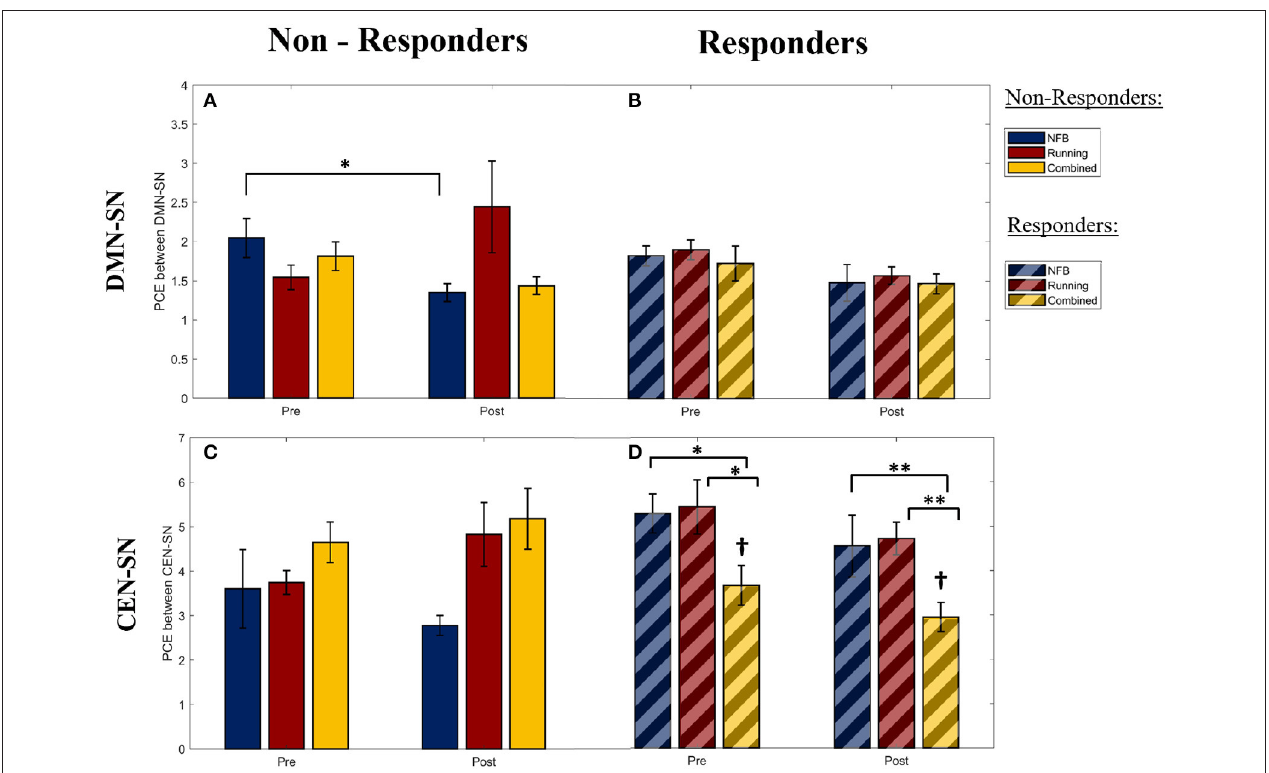
FIGURE 4 | The pairwise cross-entropy (PCE) between the DMN/CEN and SN networks during WM trials (a lower PCE value indicates higher DMN/CEN-SN synchrony). PCE is calculated for the DMN-SN pair within the Non-Responders (A) and Responders (B) , for the CEN-SN pair within the Non-Responders (C) , and Responders (D) . Significance of post-hoc pairwise independent samples t -tests are represented by * p < 0.05 and ** p < 0.01. † Represents a significant difference ( p < 0.05) with respect to Non-Responders within the Combined group at the corresponding timepoints. Error bars shown are ± 1